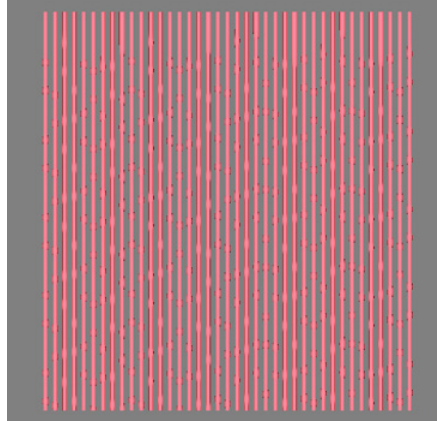
Figure 17. The imitated electronic blackboard.